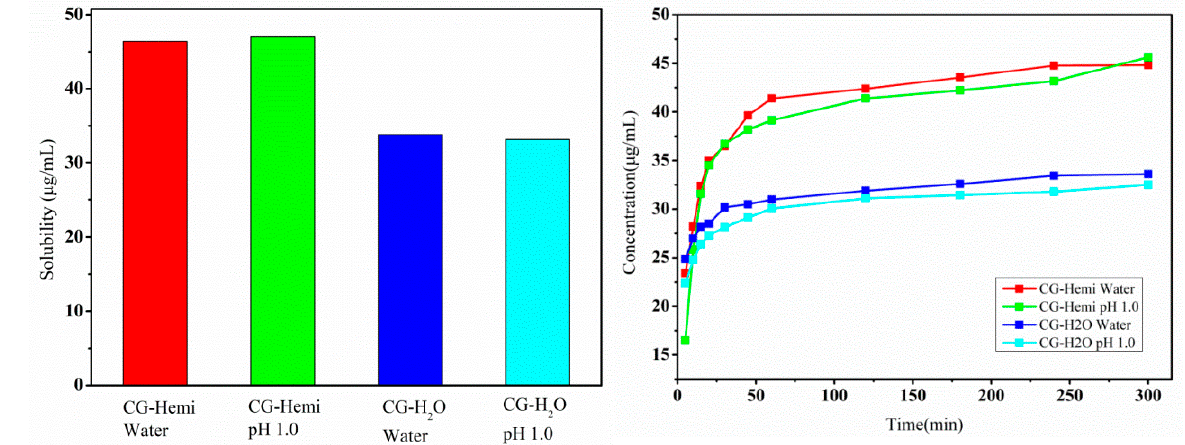
Figure 5. Solubility (left) and dissolution study (right) results of CG-Hemi and CG-H 2 O.